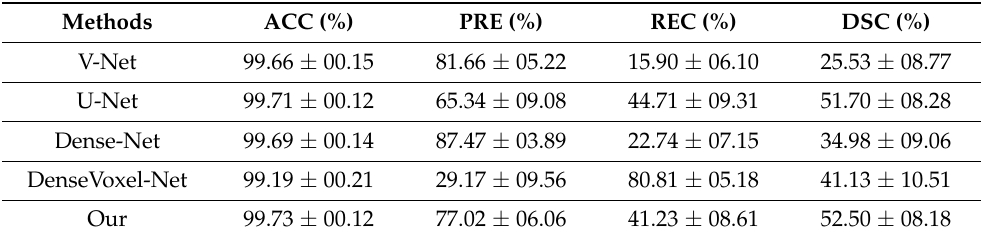
Table 9. ACC, PRE, REC, and DSC comparison of the segmentation with different methods on public dataset (compared with the manual ground